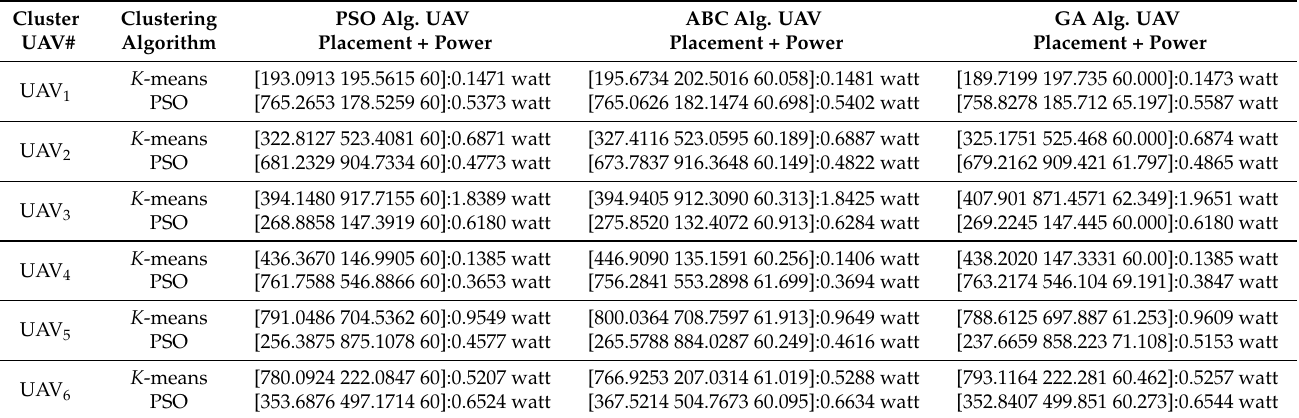
Table 5. Simulation results of the power-efficient algorithm for non-uniform distribution